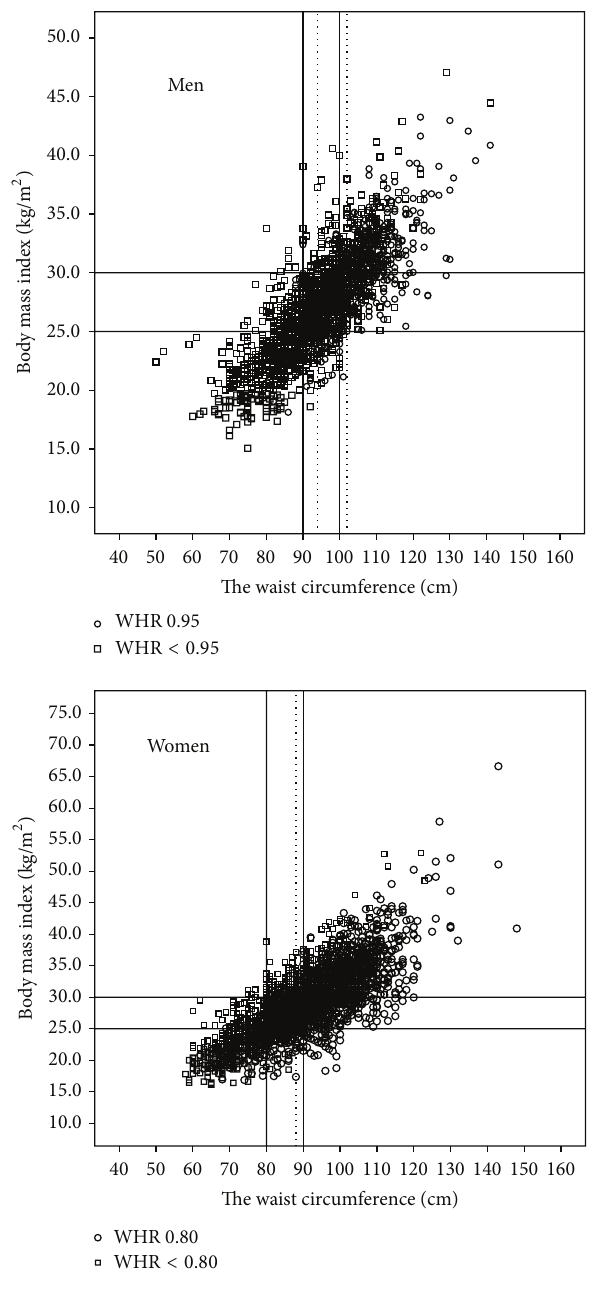
Figure 1: The relationship of waist circumference (WC) and body mass index in Turkish adults and cutoff values of WC both recommended by World Health Organization and calculated in the present study. The relation between WC levels and BMI in men and women and the two action levels of WC that identify subjects with BMI ≥ 25 kg/m 2 or ≥ 30kg/m 2 and with WHR ≥ 0.95 for men and ≥ 0.80 for women. Dotted lines show action levels 1 and 2 recommended by the WHO. Solid lines show the action levels determined by the present study. ∘ indicates the individuals with WHR ≥ 0.95 (in men) and ≥ 0.80 (in women); false negative in upper left quadrant. ◻ indicates the individuals with WHR < 0.95 for men and < 0.80 for women; false positive in lower right quadrant. Linear Regression: BMI = ( WC × 0.297) − 0.975 in men; BMI = ( WC × 0.338) − 1.32 in